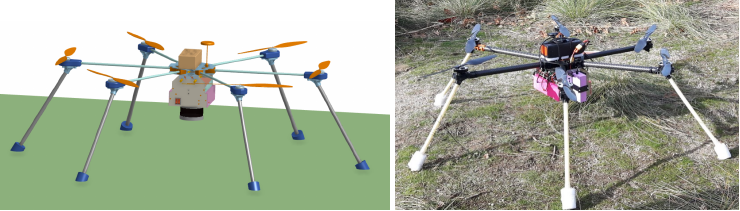
Figure 15. Drone and Sensorbox on the ground: CAD ( left ) and photograph, before takeoff ( right